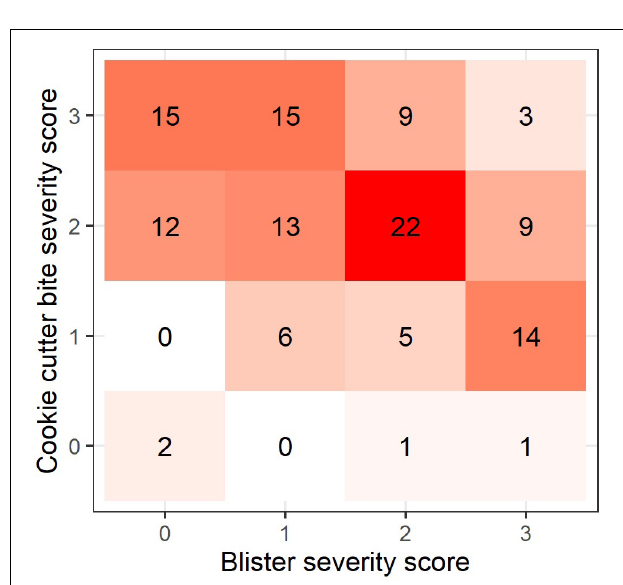
FIGURE 3 | Heatmap showing the pattern of co-occurrence in blister and cookie cutter shark bite severity ( n = 127). Numbers and colors within each square represent the number of cases for each co-occurrence